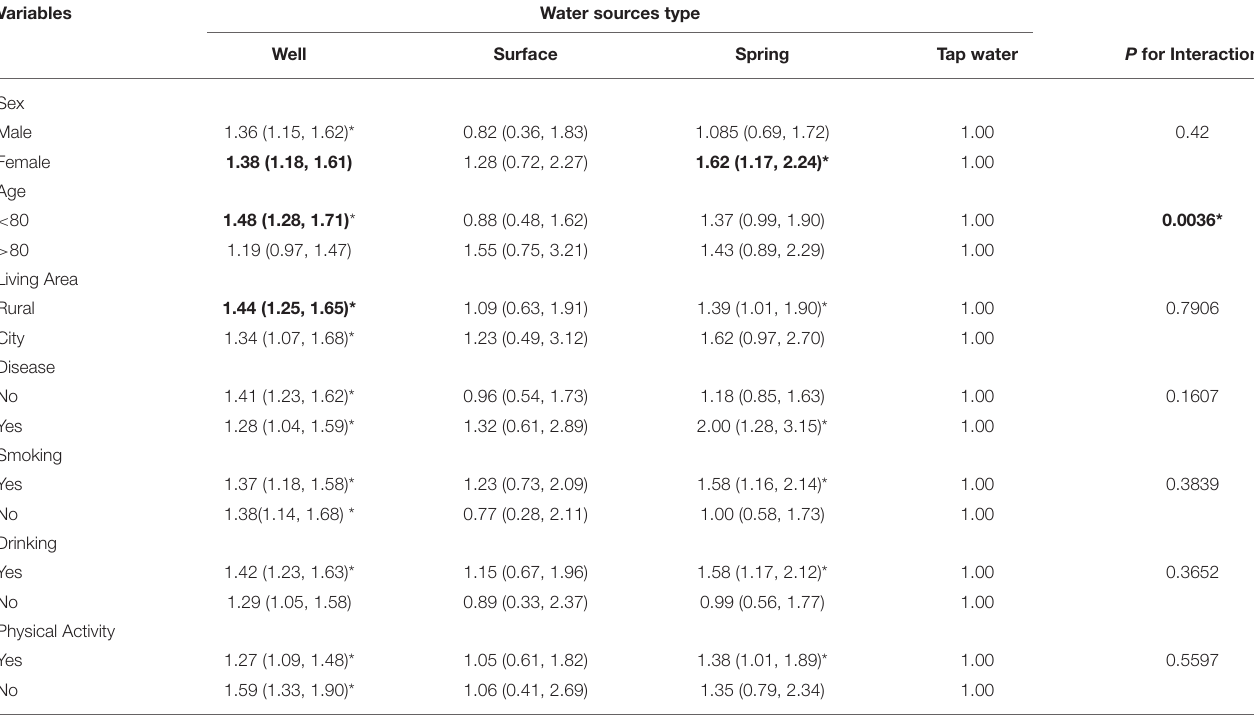
TABLE 3 | Hazard ratio and 95% CI of OA in participants drinking from different water sources stratified by participants’ characteristics.